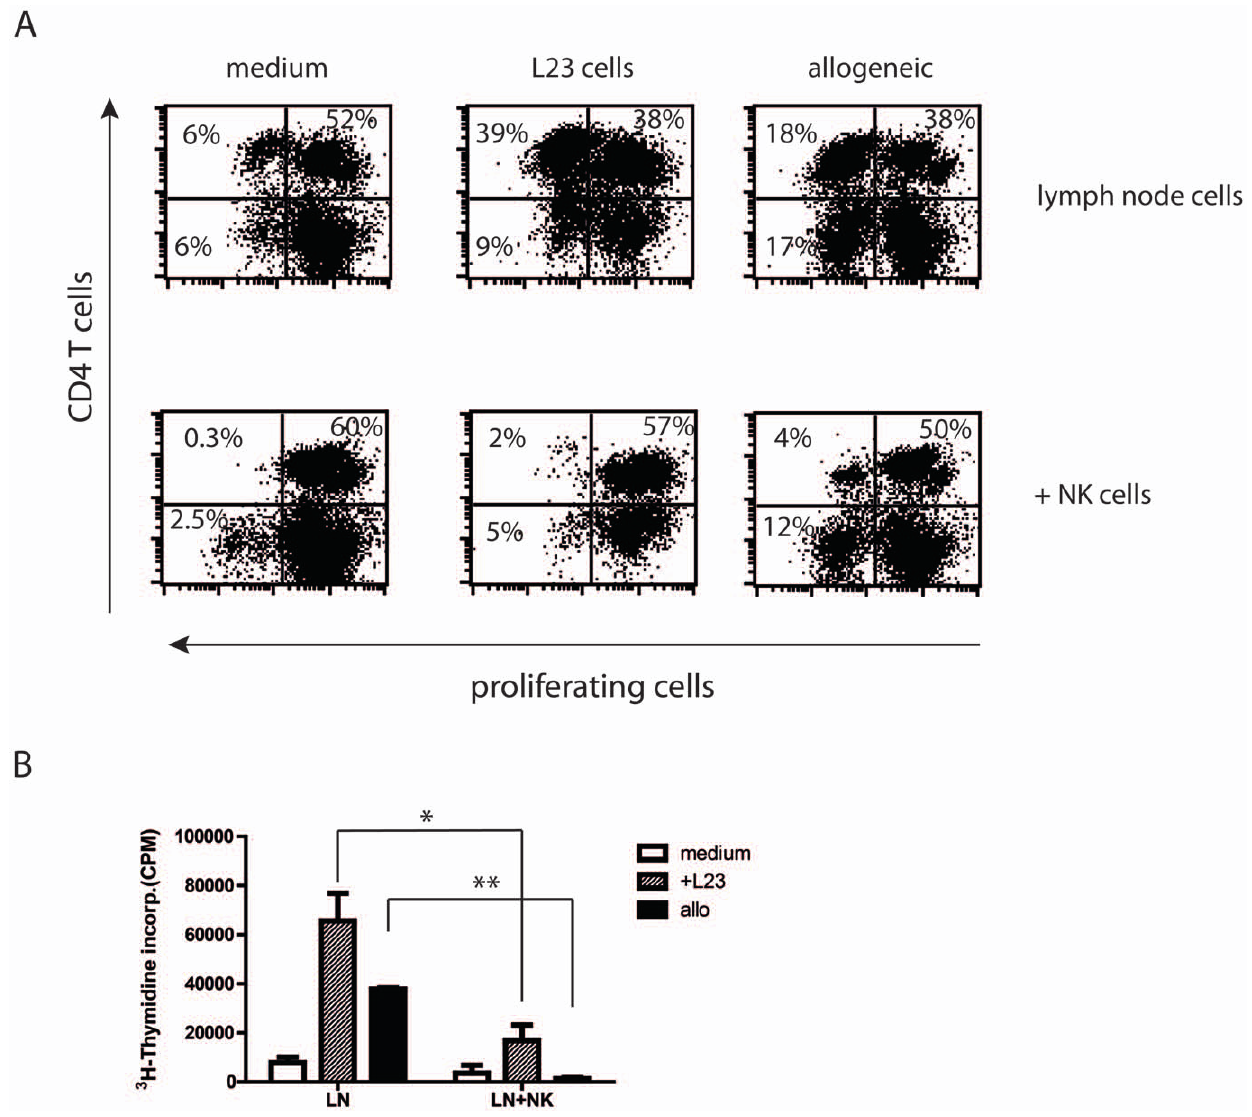
Figure 4. NK cells control the response of lymph node cells. A: Representative scatter gram of proliferating lymph node cells with or without supplement of autologes NK cells. 2 6 10 5 lymph node cells from naive congenic LEW.BH-NKC were stimulated with 2 6 10 3 porcine L23 cells or 2 6 10 5 fully disparate spleen cells from Lew.1w rats in the absence or presence of 2 6 10 4 negative isolated naive NK cells. LEW.BH-NKC cells were labelled with fluorescent dye CMFDA to follow proliferation in flow cytometry. B: Proliferation was also assessed by analysis of 3 H thymidine incorporation to confirm flow cytometric results. The presence of NK cells drastically diminished the response of lymph node cells. Results shown as scatter grams represent a bulk of three independent experiments. Graph summarises results of at least three independent experiments as mean 6 standard deviation. *p # 0.05; **p # 0.01.